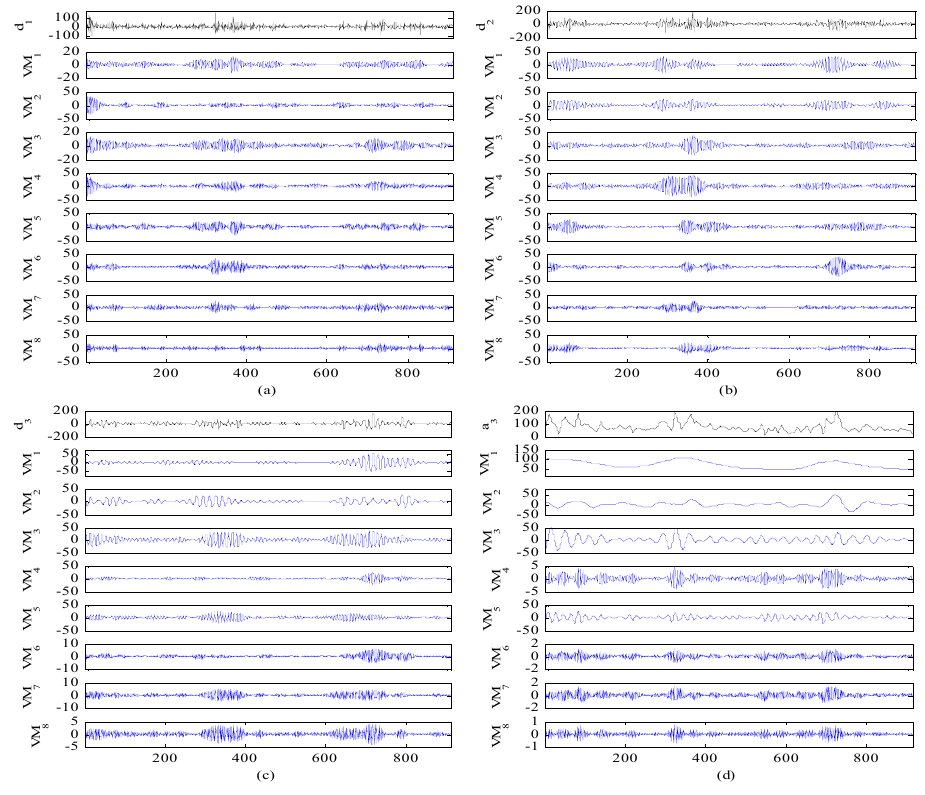
Figure 16. Decomposition results of each subset by VMD (Tianjin).